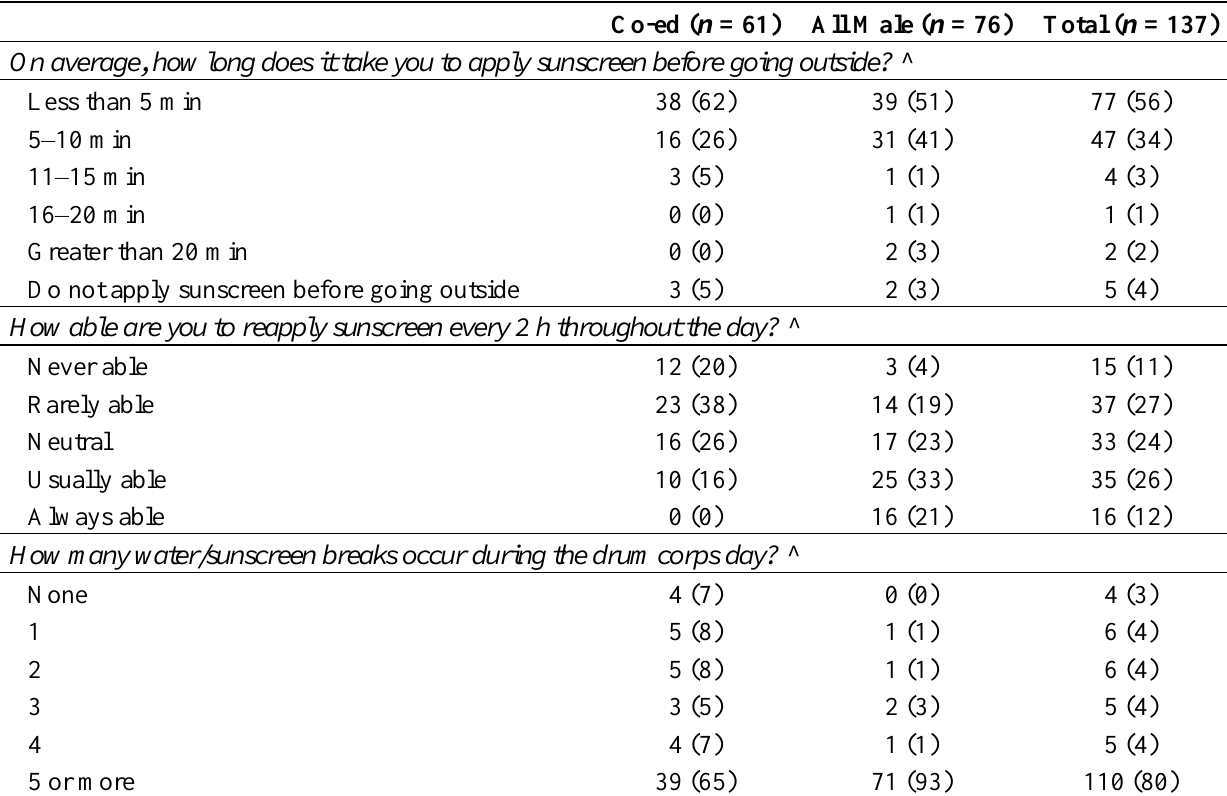
Table 2. Barriers to sunscreen